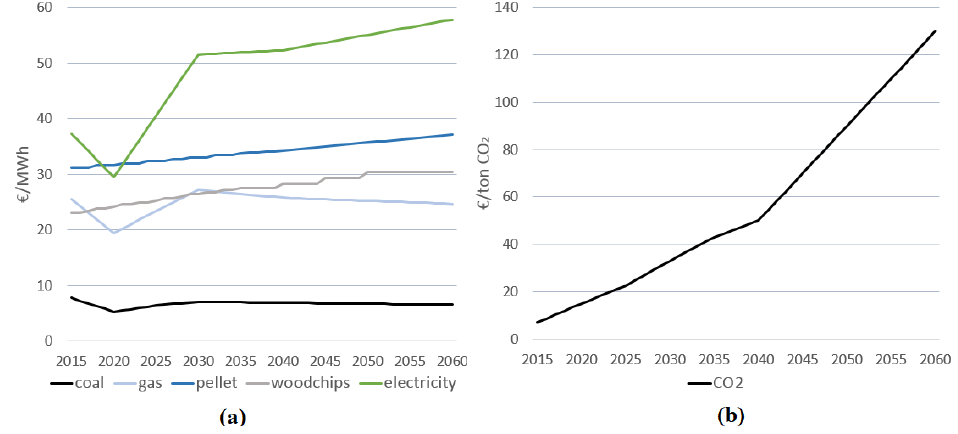
Figure 1. Development of fuel and electricity ( a ) and CO 2 ( b ) pricing